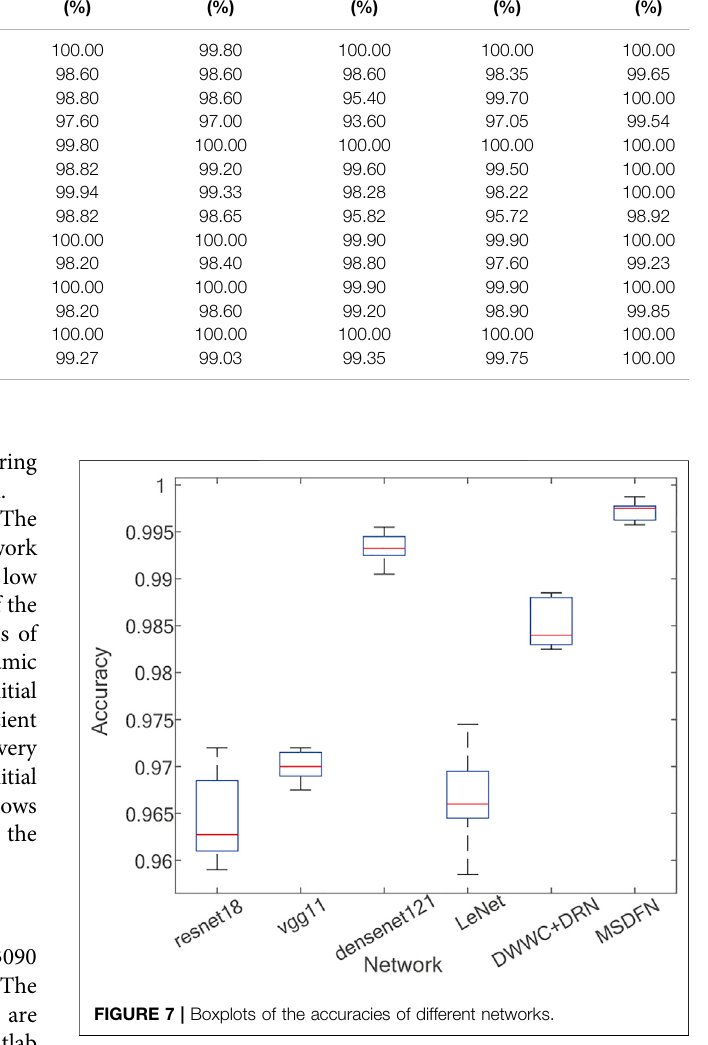
TABLE 7 | Accuracy of different methods on different dataset. Network